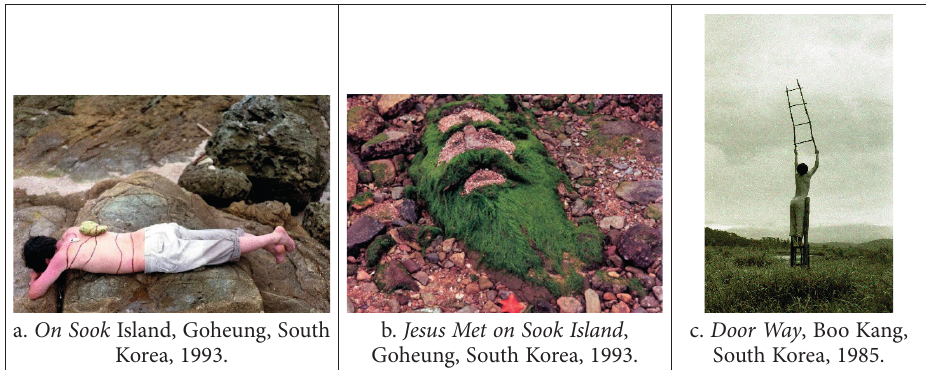
Table 2. Works reflecting Seung-Hyun Ko’s religious piety (source: Courtesy of